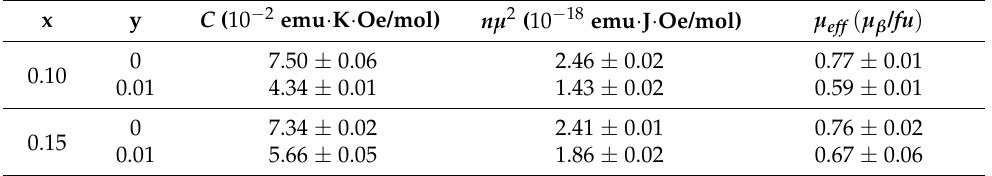
Table 2. Magnetic parameters values of Eu 2 − x Ce x Cu 1 − y Zn y O 4+ α − δ with x = 0.10; 0.15 and y = 0;